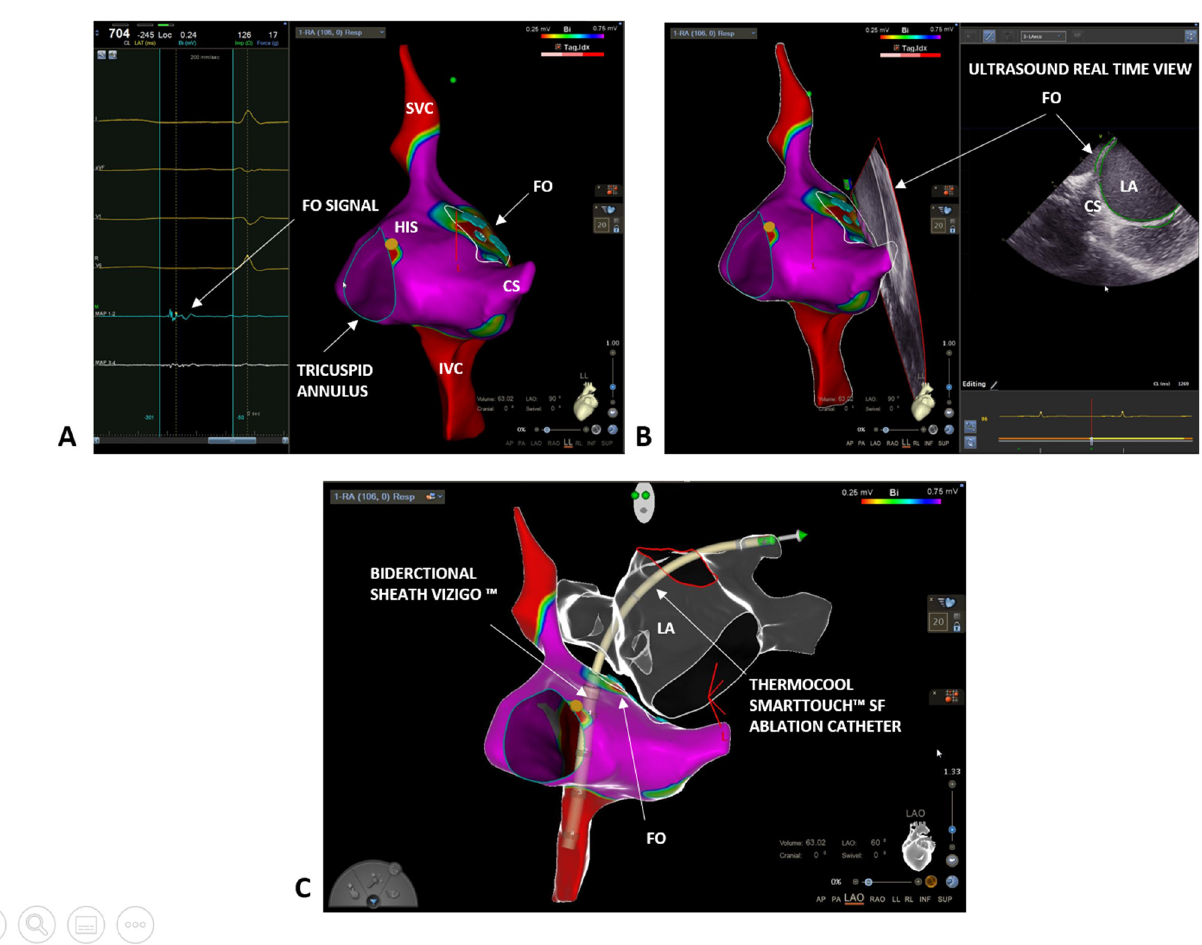
Figure 1. ( A ) Right atrium bipolar map (0.25–0.75 mV) with ThermoCool SmartTouch™ SF in a left lateral (LL) projection: blue tags indicate fragmented and low voltage signals, typical of the fossa ovalis (FO) area; yellow tags indicate His location. ( B ) Confirmation of FO location with ICE imaging and co-registration on the electro-anatomical map (LL projection) with CartoSound ® module. ( C ) Transseptal puncture with the bidirectional steerable sheath VIZIGO™ in a left anterior oblique (LAO) projection with the ablation catheter in the left superior pulmonary vein. Left atrium showed in glass mode. FO = fossa ovalis, LA = left atrium; SVC = superior vena cava; IVC = inferior vena cava; CS = coronary sinus.